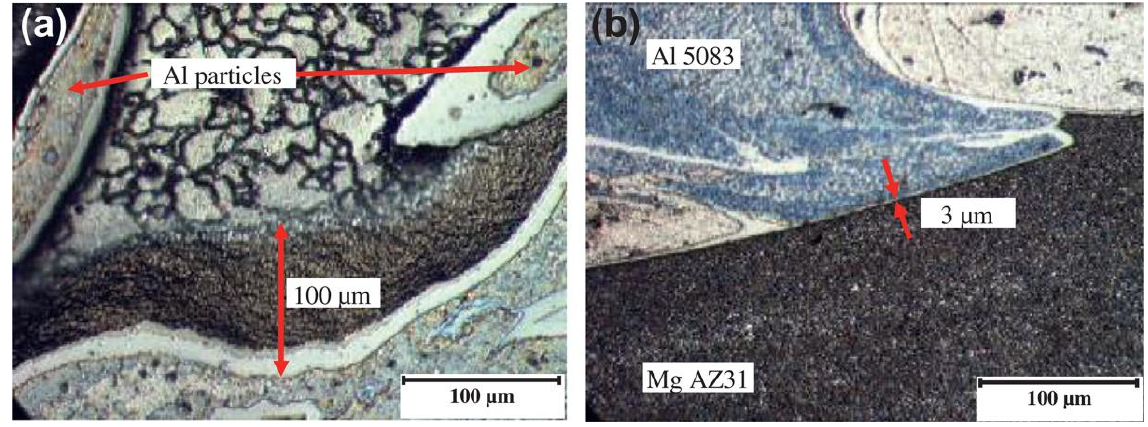
Figure 4. Microstructure of Al/Mg interface for ( a ) friction stir welded specimen in air and ( b ) submerged friction stir welded specimen under